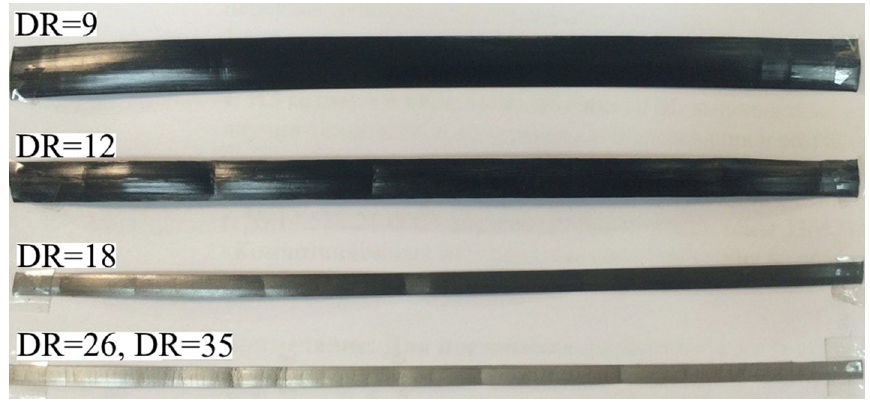
Figure 3. Photo of bulk oriented films based on UHMWPE/1% FMWCNT with different draw ratios (DR). DR is indicated in the figure.